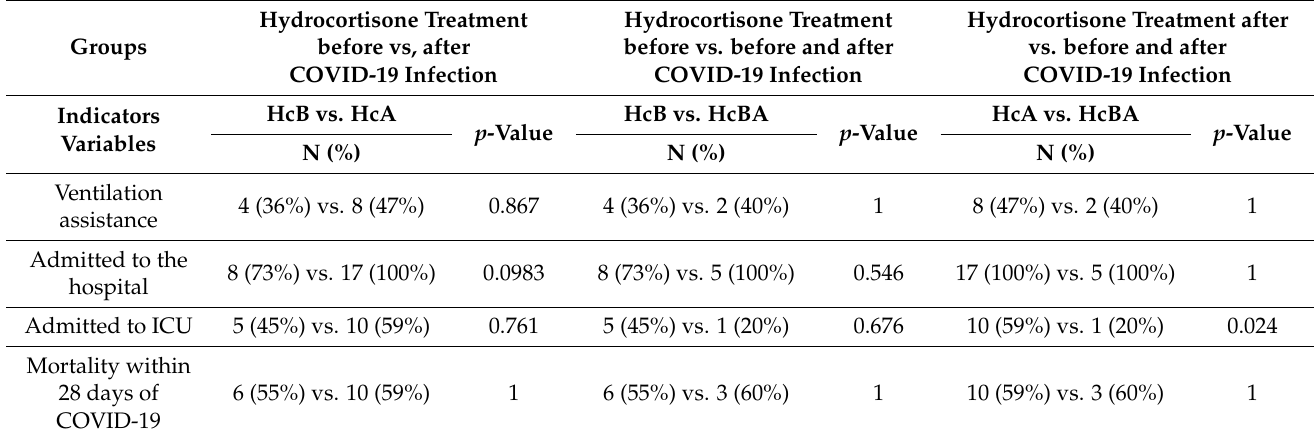
Table 4. Effect of hydrocortisone treatment before and after COVID-19 infection on disease indicators.